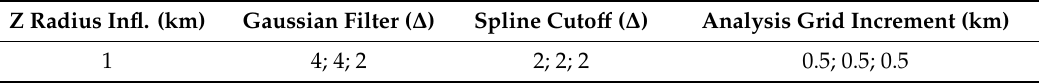
Table 3. Spline Analysis at Mesoscale Utilizing Radar and Aircraft Instrumentation (SAMURAI) main configuration for the study. ∆ is the length scale used for the filters (horizontal and vertical grid scale). Z Radius Infl.